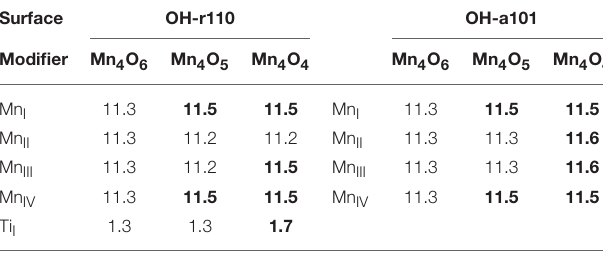
TABLE 1 | Computed Bader charges for the manganese ions in the supported nanoclusters before and after formation of one or more O V . Surface